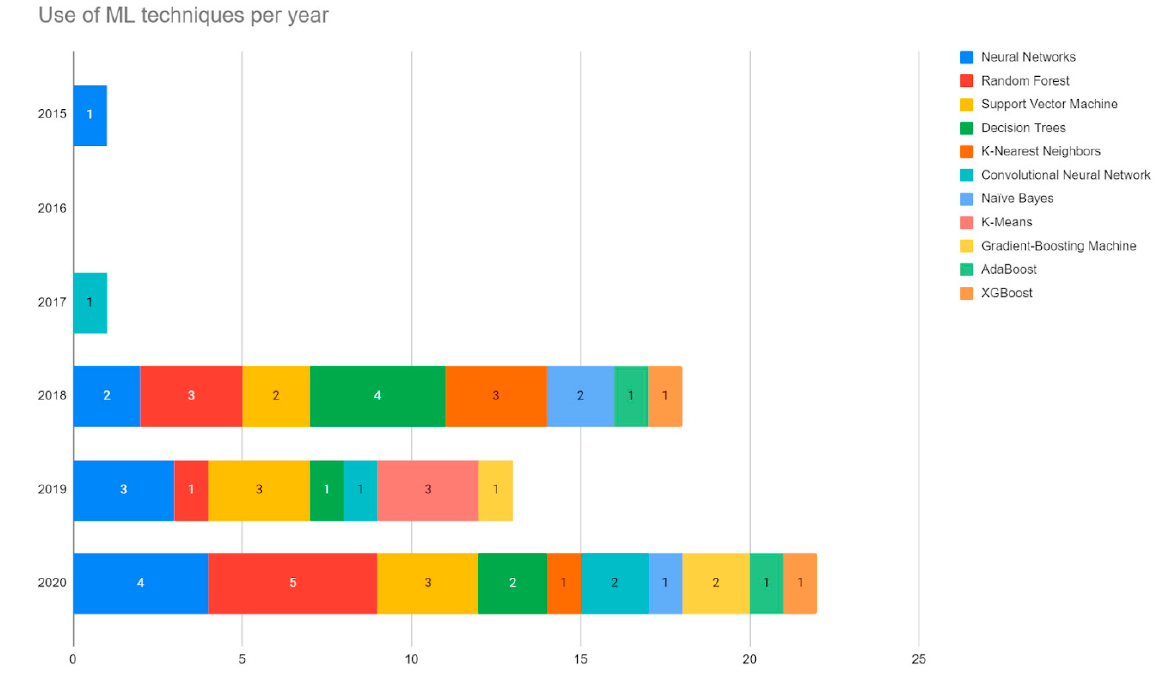
Figure 16. Main ML techniques used in agricultural Big